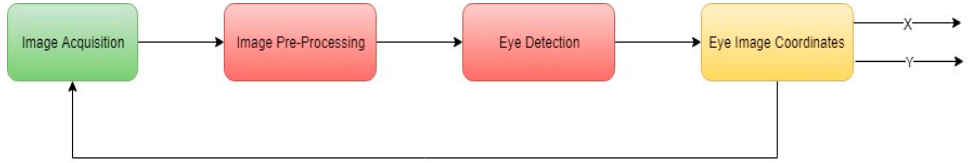
Figure 3. Structure and functionality of real-time eye tracking algorithm.